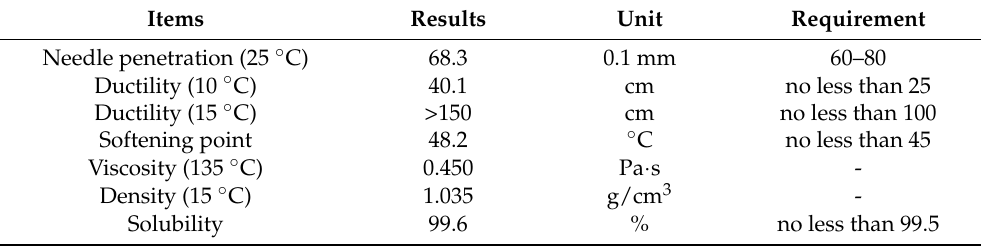
Table 1. Properties of AH-70 bitumen.